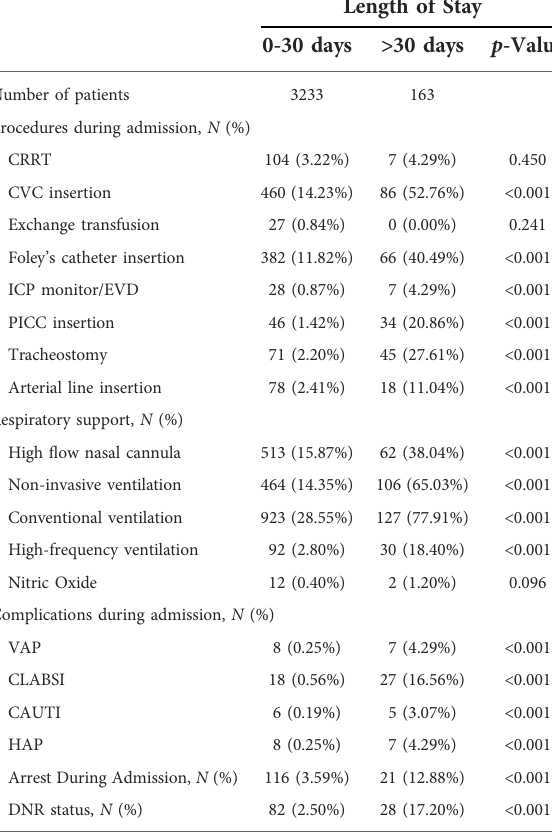
TABLE 2 Characteristics of admission according to the length of stay. TABLE 3 History of admission according to the length of